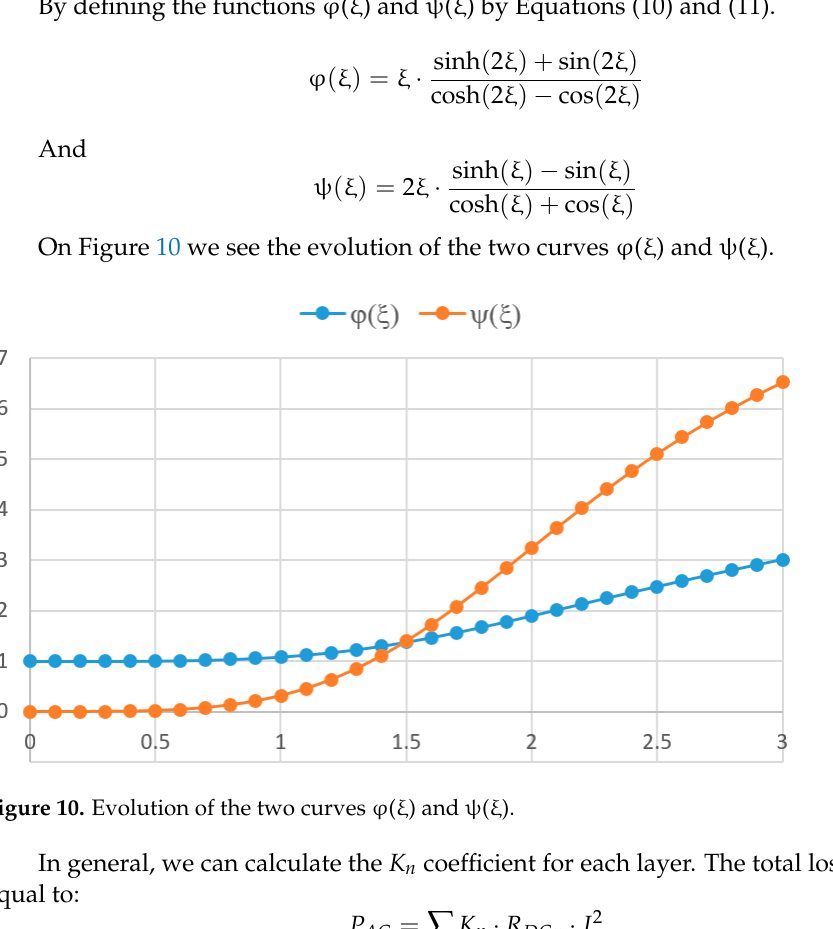
Figure 10. Evolution of the two curves φ ( ξ ) and Ψ ( ξ ).